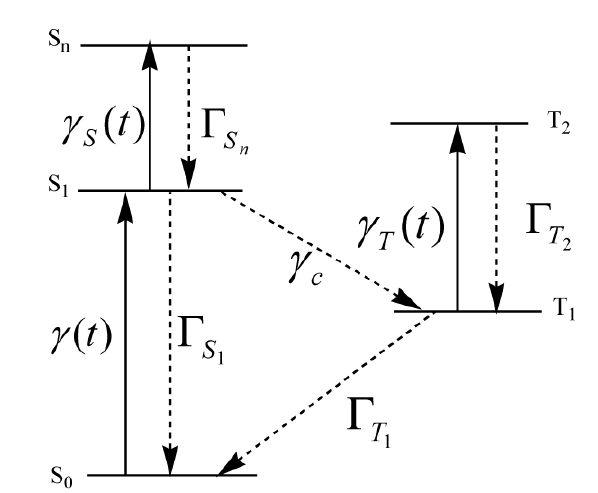
Figure 2. The Jablonski diagram of a five-level